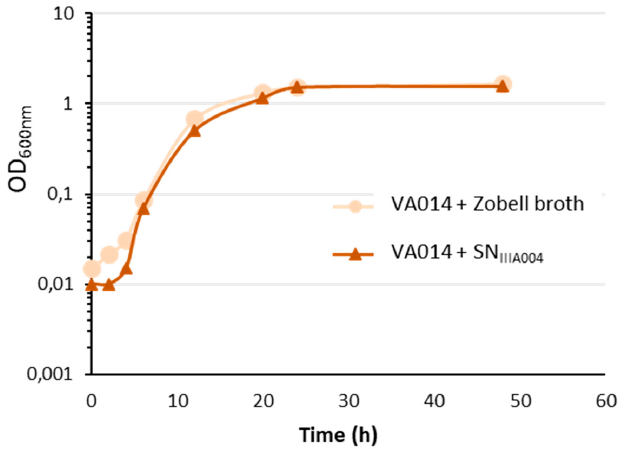
Figure 3. Growth curves of Roseovarius sp. VA014 pre-incubated with Zobell broth (control) or SN IIIA004 for 2 h. The growth was monitored by measuring the OD 600nm .